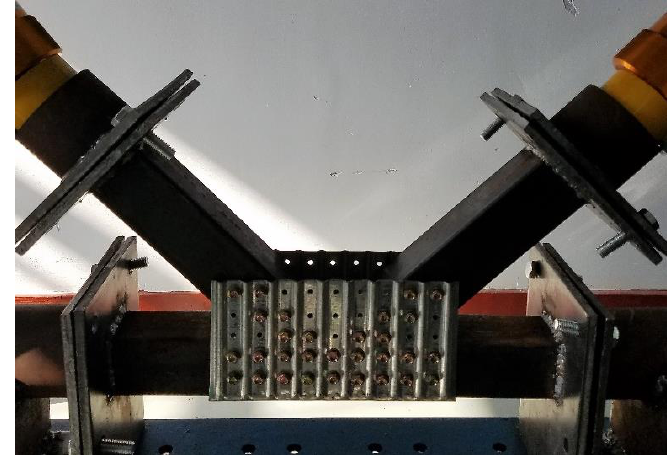
Figure 5. Connection between the U-shape connector and the chord.